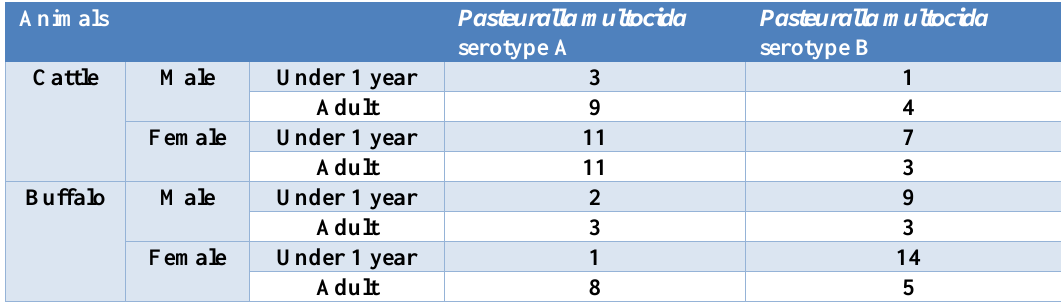
Table, 4: Shows types of samples taken from cattle and the positive cases infected with HS. Place Samples of cattle